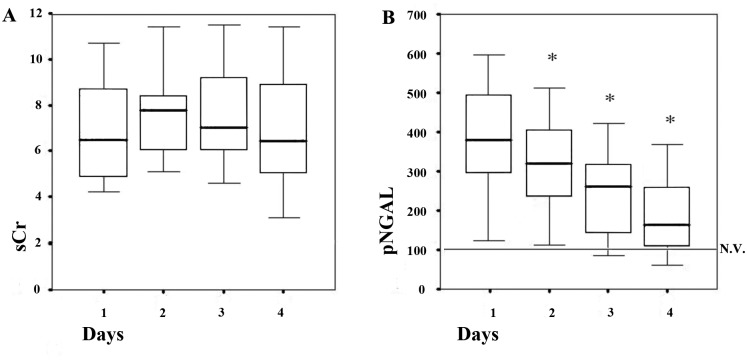
Evaluation of serum creatinine (sCr in A) and plasma NGAL (pNGAL in B) in the first 4 consecutive days after KT in non-DGF patients (n = 36).NGAL significantly decreased starting from day 2 to day 4 after KT reaching a value near to normal levels (100 ng/ml). Each value of pNGAL was significantly lower in comparison to the previous day (*p<0.05). By contrast, sCr remained stable or even increased (p>0.05).